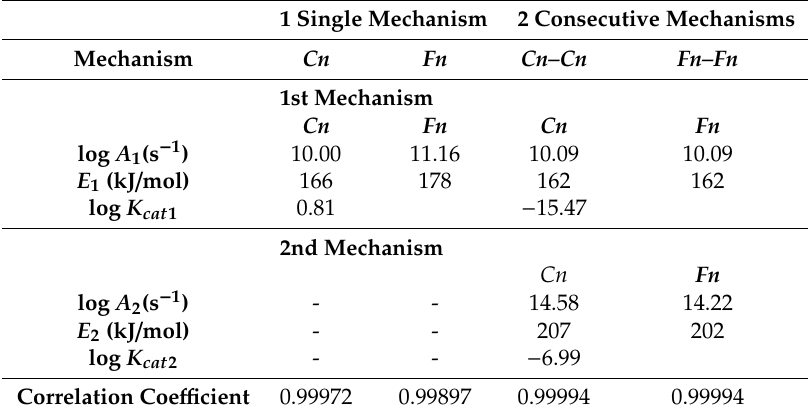
Table 1. Results of the model-fitting method for PEV.